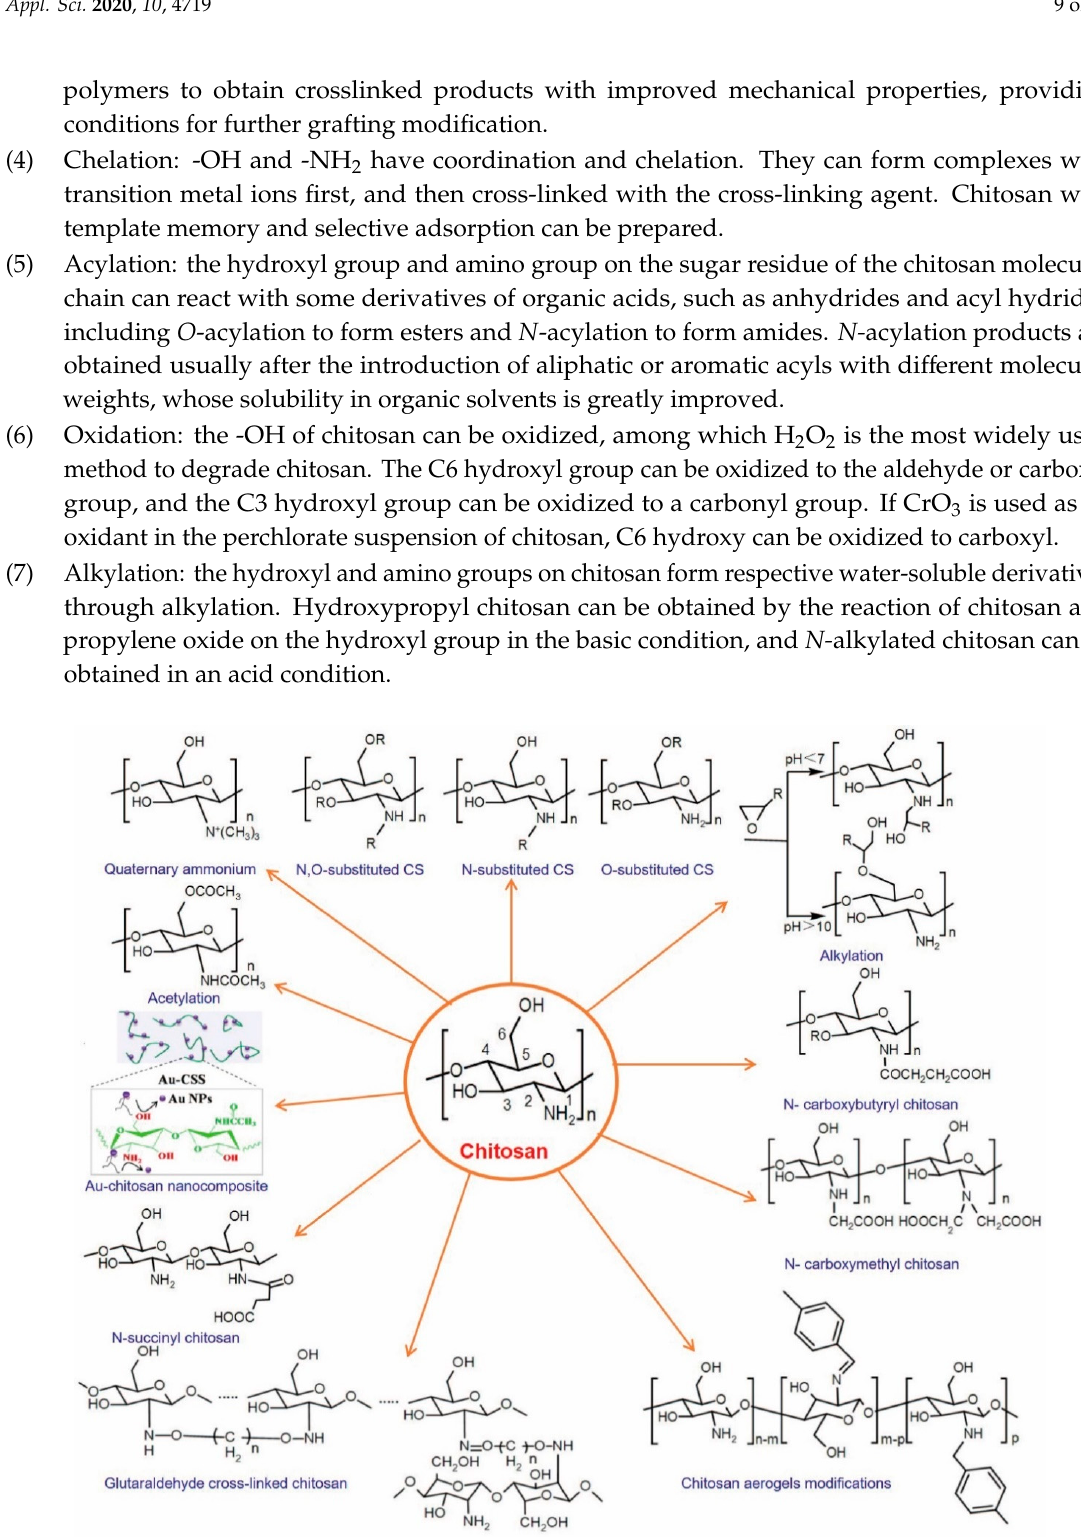
Figure 4. Chemical structure of di ff erent types of chemical modification of